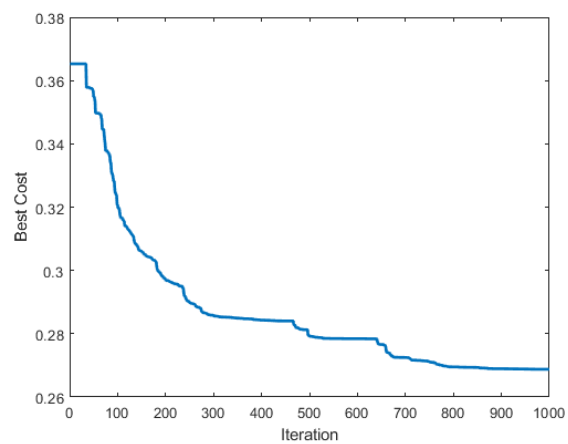
Figure 10. Objective function convergence diagram (GA-SA algorithm).